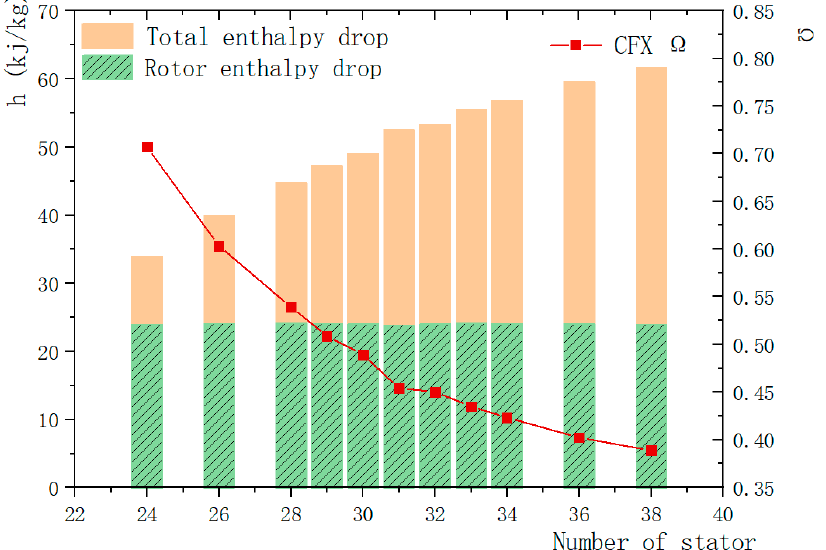
Figure 6. The influence of the number of stator blades on the total enthalpy drop of the turbine, the enthalpy drop of the rotor and the reaction degree.